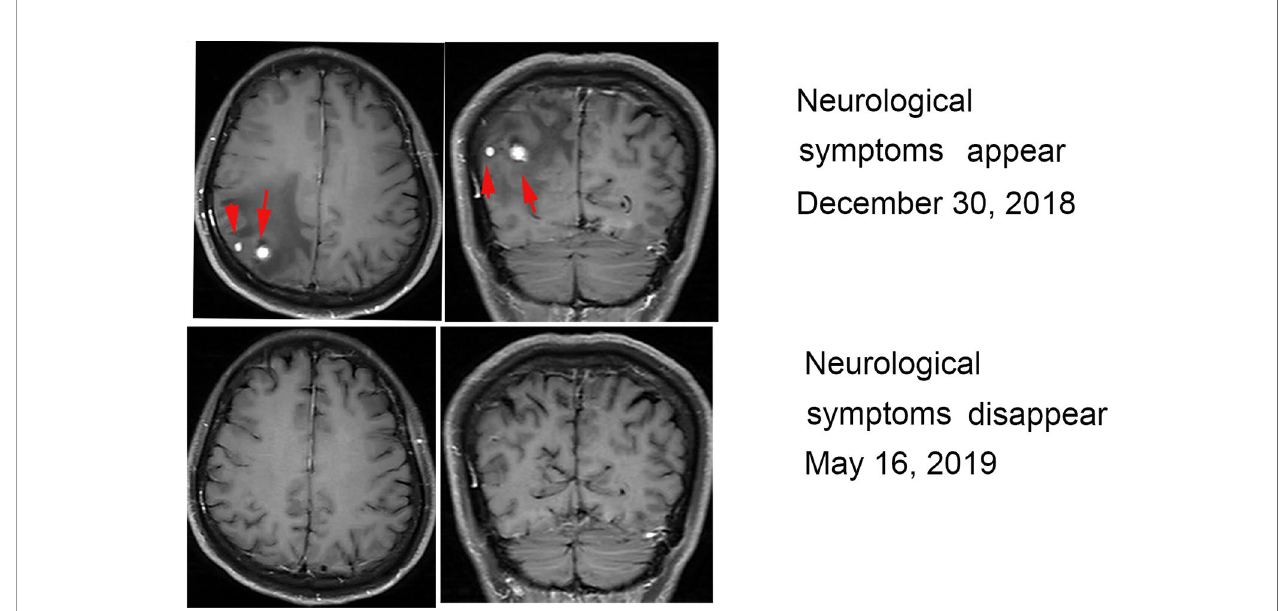
FIGURE 2 | MRI during treatment with nivolumab and CIK cells. MRI revealed two enhancing metastatic lesions within the brain parenchyma 6 months after the initiation of treatment. The brain lesions disappeared after 6 months of continued treatment.